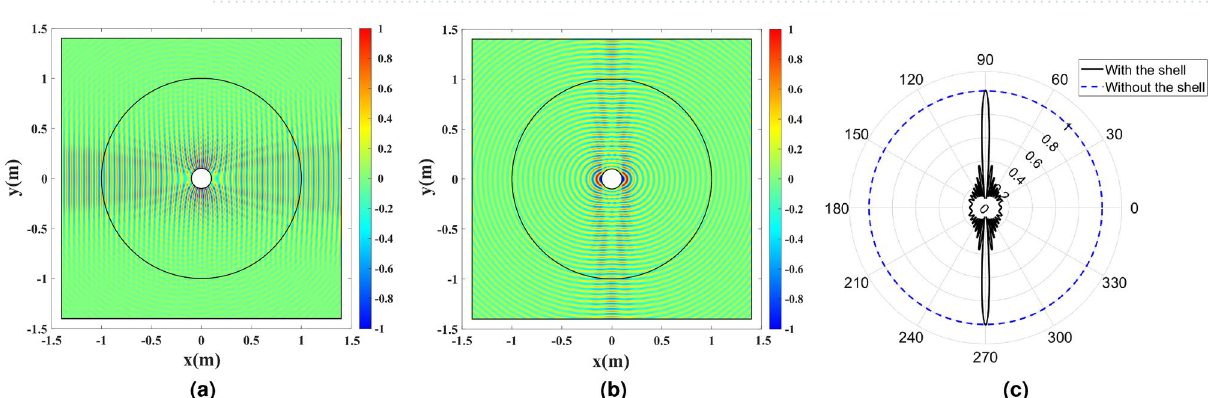
Figure 11. Full-wave simulation results for the cylindrical wire enclosed by the refractive index depicted in Fig. 9. ( a ) The amplitude of H z for a TM Gaussian wave illuminating the structure. ( b ) The amplitude of E z for the wire excited by the uniform electric current density J z at 3 GHz. ( c ) The normalized far-field pattern with and without the dielectric